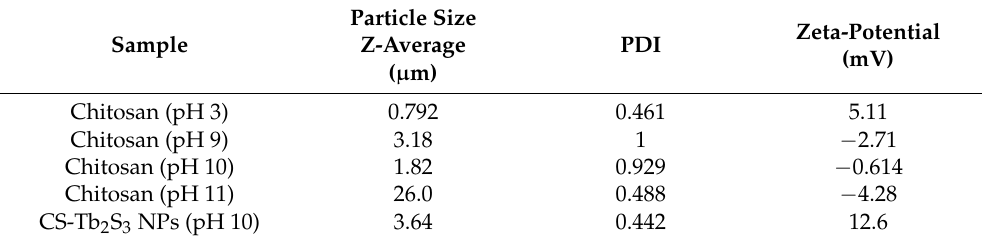
Table 2. DLS and zeta-potential results for chitosan at variable pH and CS-Tb 2 S 3 nanoparticles at 295 K.